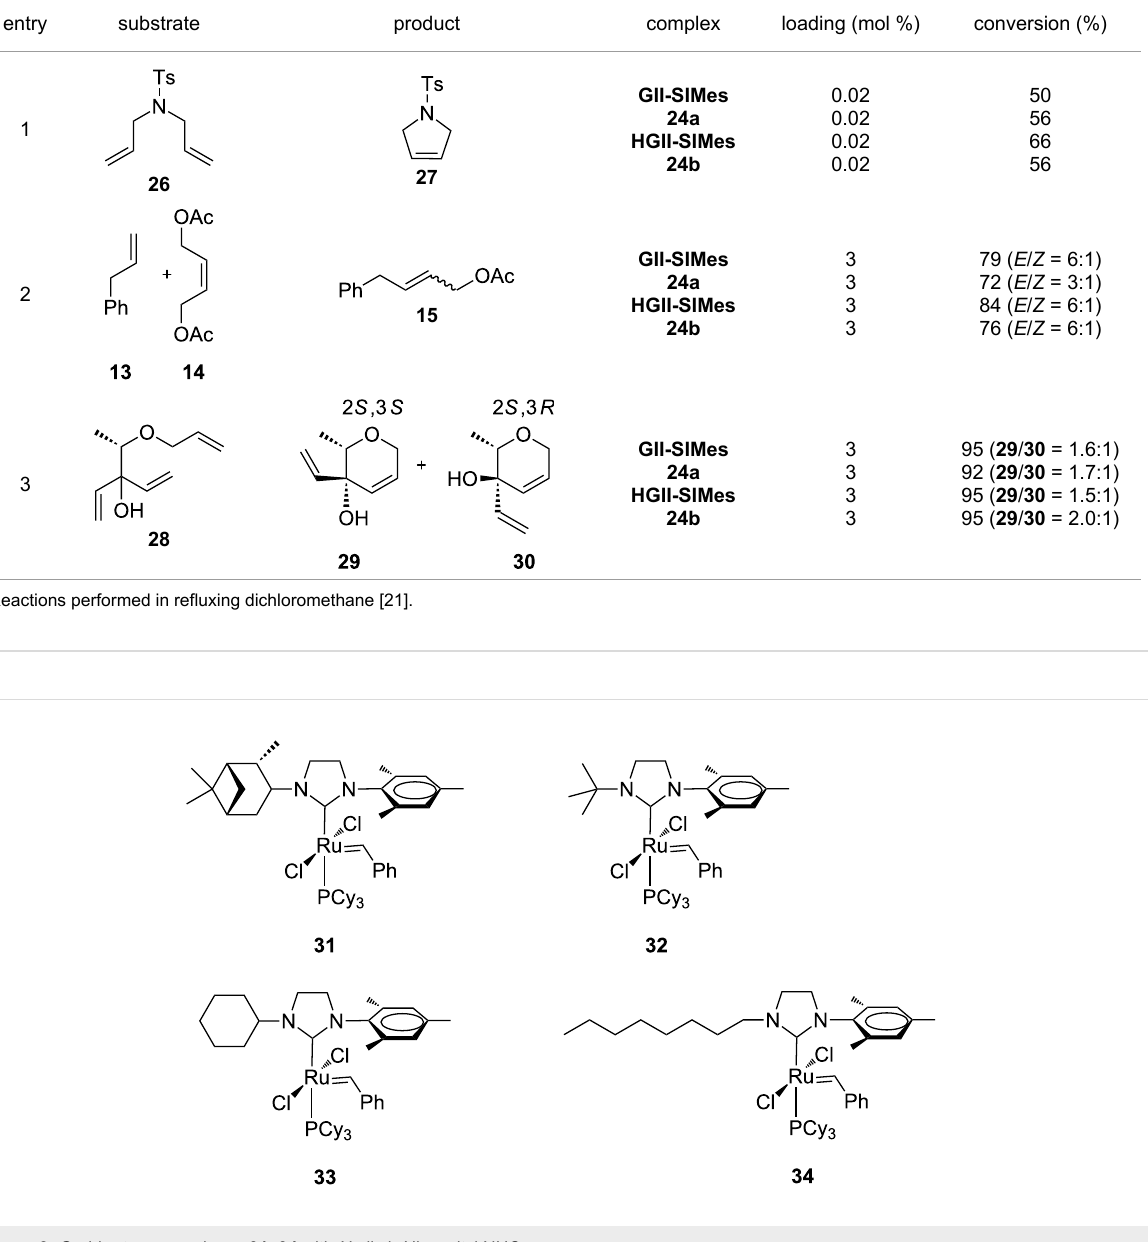
ing the small methyl moiety on the nitrogen, revealed as the best performing catalyst, even surpassing the parent complex GII-SIMes . In the ROMP reaction (Scheme 5), carried out in different solvents and monomer/catalyst ratios, the activities of complexes 31 , 33 and 34 were superior to that of the symmetri- cal counterpart GII-SIMes at low COD/catalyst loading in CDCl 3 . In general, the complexes were less dependent on the solvent used with respect to GII-SIMes . Catalyst 32 , having a bulky N - tert -butyl substituent on the NHC, displayed a consid-